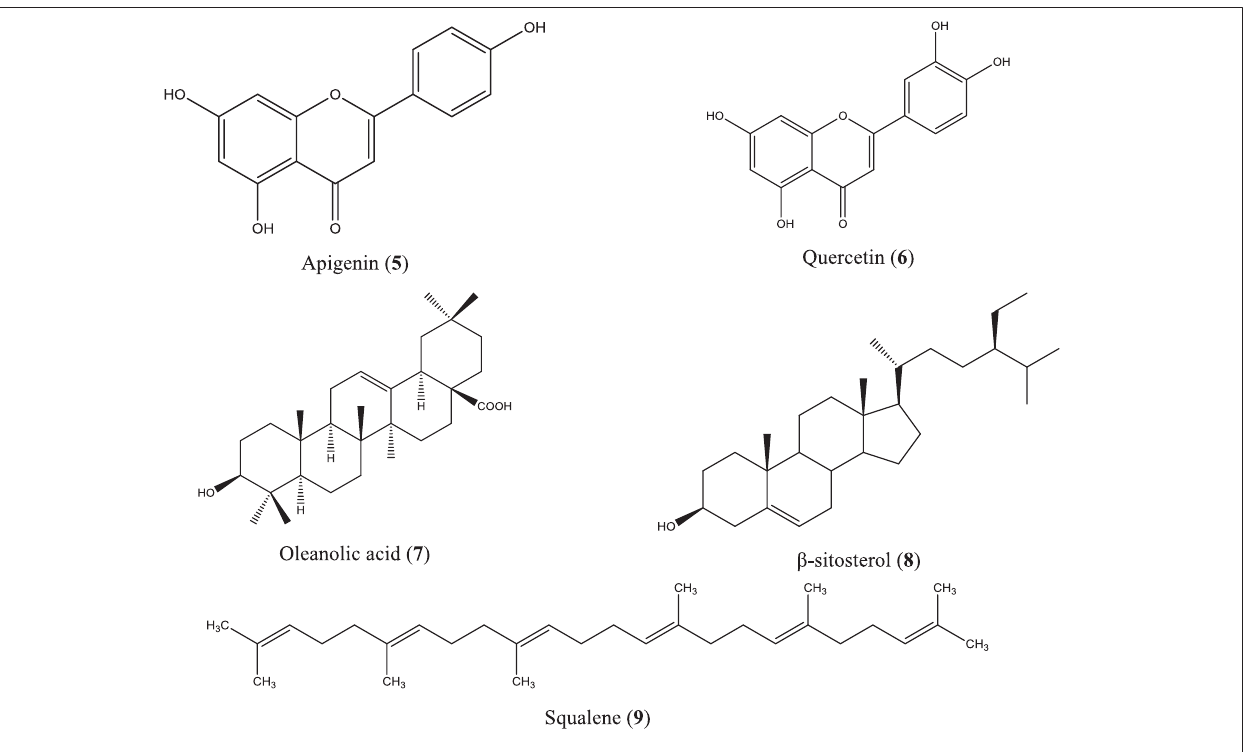
FIGURE 4 | Anti-in fl ammatory compounds isolated from C. infortunatum .